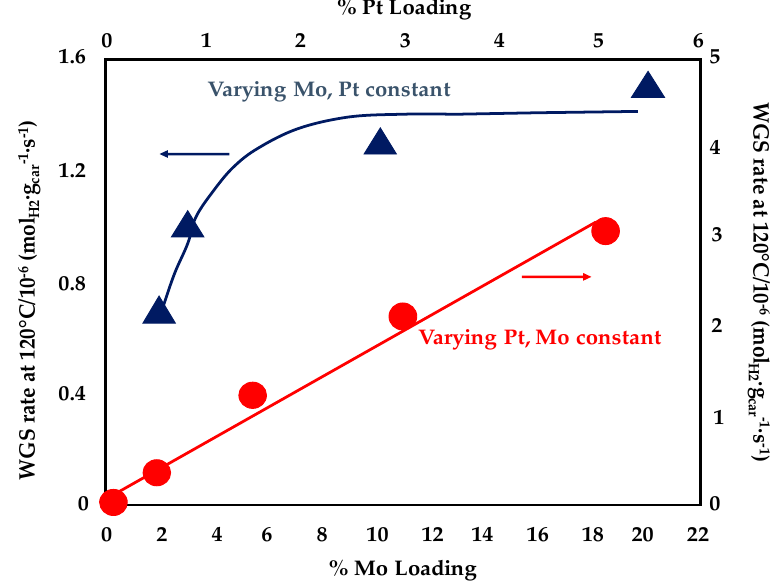
Figure 14. WGS rate per gram of catalyst at 120 ◦ C as a function of Pt and Mo lading for Pt / Mo 2 C / MCNT adapted from [91], with permission from Elsevier, 2015; P = 1 atm, 7% CO, 22% H 2 O, 8.5%, CO 2 , 37.5% H 2.